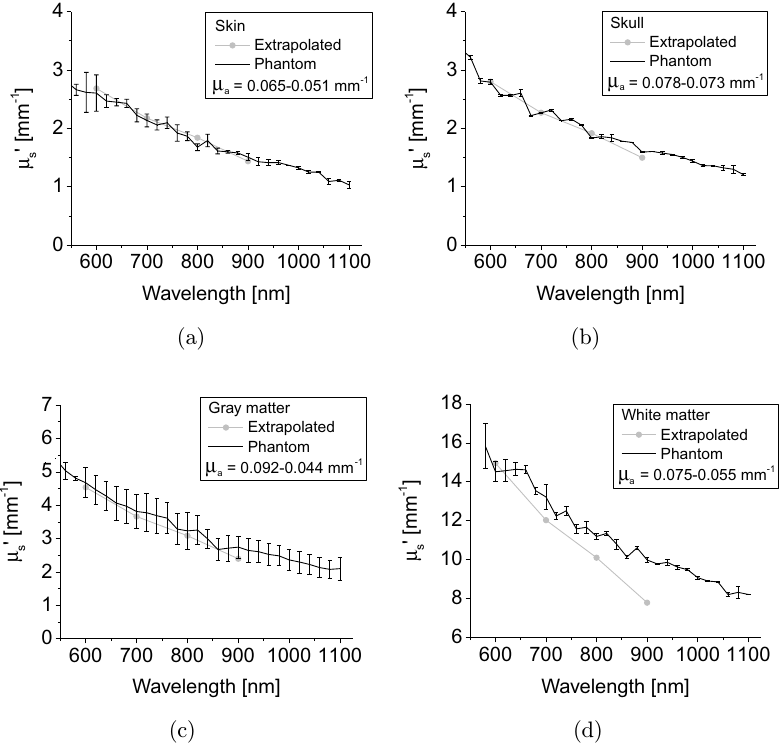
Fig. 5. Reduced scattering coe±cients of the head-mimicking layers. Linear extrapolation based on the single-scattering phantom measured at 900-nm wavelength (\Extrapolated"), and results of measurements of the fabricated phantoms, simulating skin (a), skull (b), gray matter (c), and white matter